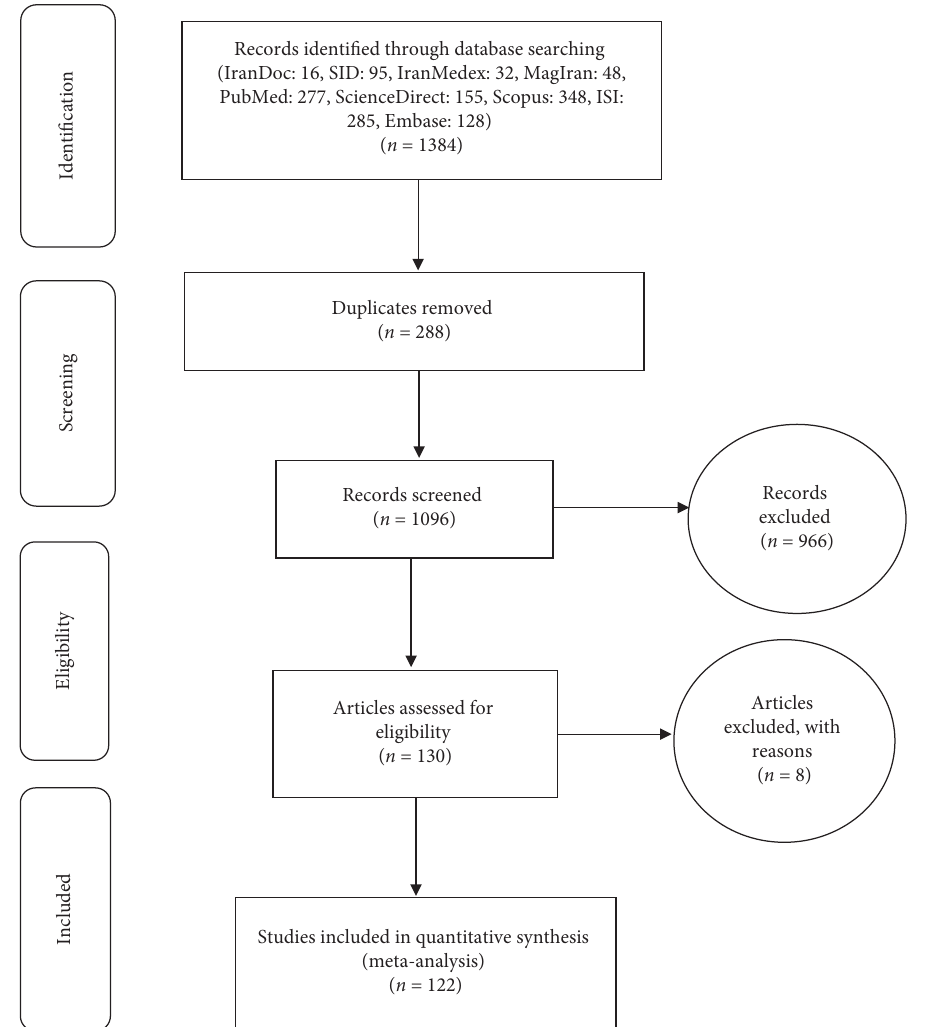
Figure 1: Flow diagram of study selection.